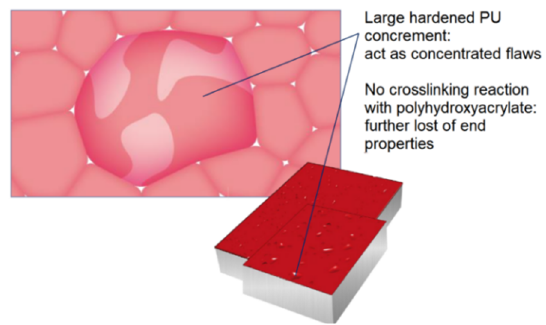
Figure 6. The process of film formation and curing of a two-component waterborne polyurethane coating. ( a ) Process of diffusion between polyhydroxyacrylate particles and polyisocyanate droplets; ( b ) Chemical crosslinking in fully diffused and fused resin.